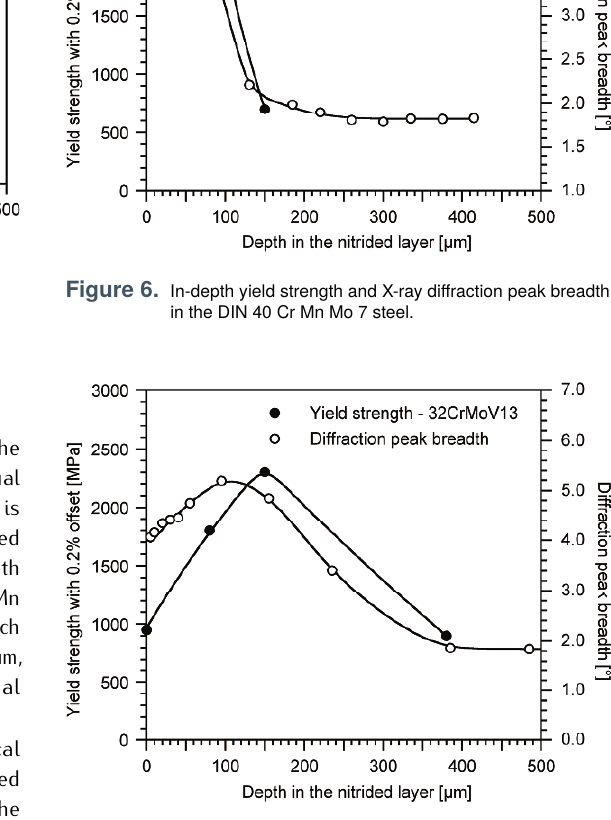
150 µm approximately, after decreasing continuously